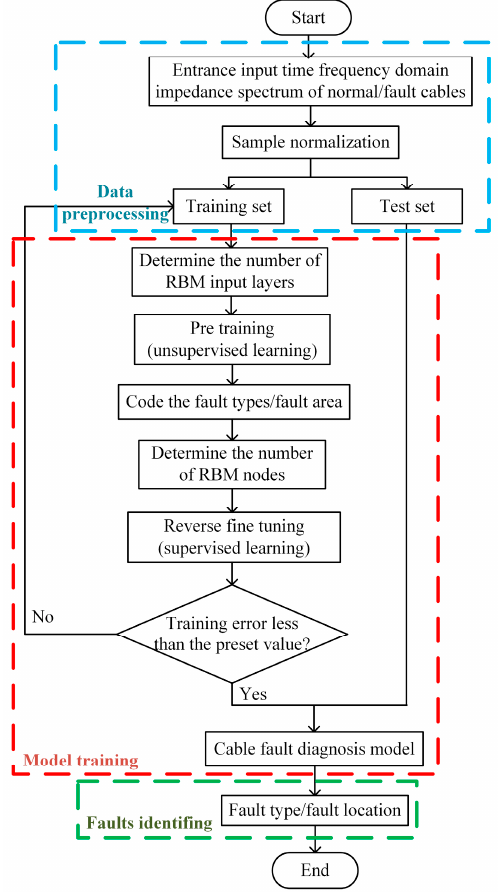
Figure 3. Cable fault diagnosis process based on DBN.